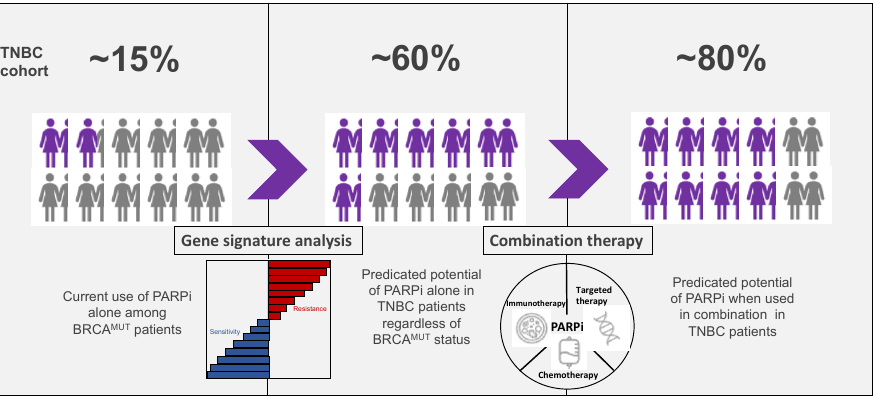
Figure 2. Projected utility of PARPi in TNBC. Currently, PARPi are used only among germline, BRCA1/2 -mutant metastatic TNBC patients, which constitute about 15% of TNBC patients. With the use of strong predictive biomarkers in early TNBC, it is plausible that PARPi sensitivity will be observed in about 60% of TNBC patients (middle panel). In combination with either chemotherapy, immunotherapy, or targeted therapeutics, PARPi sensitivity can potentially increase to 80% of TNBC patients (right